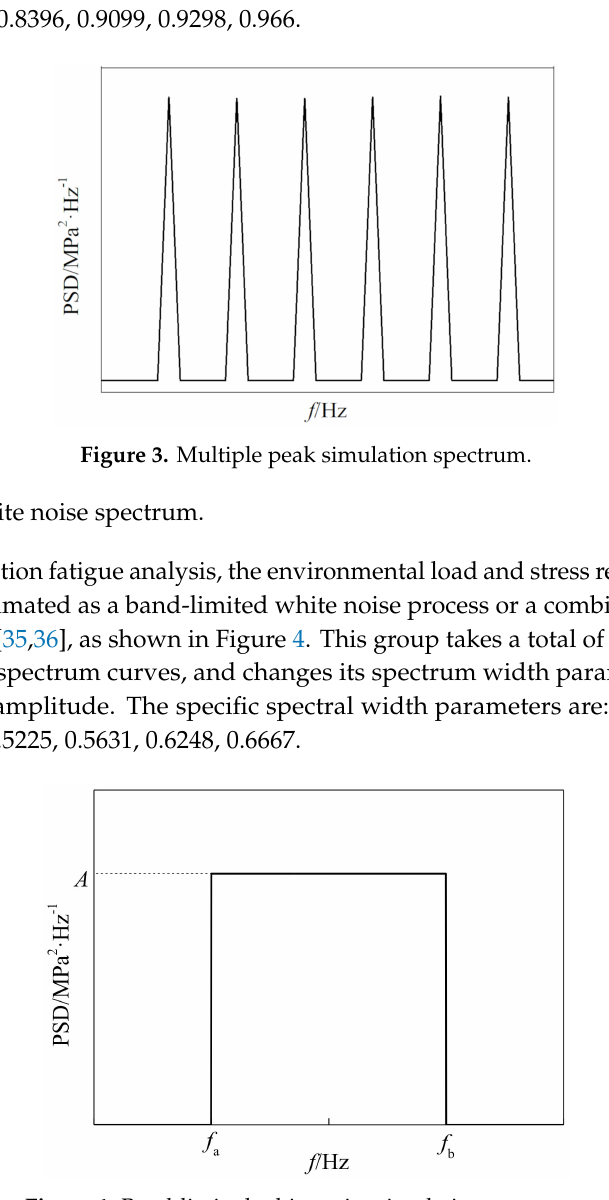
Figure 4. Band-limited white noise simulation